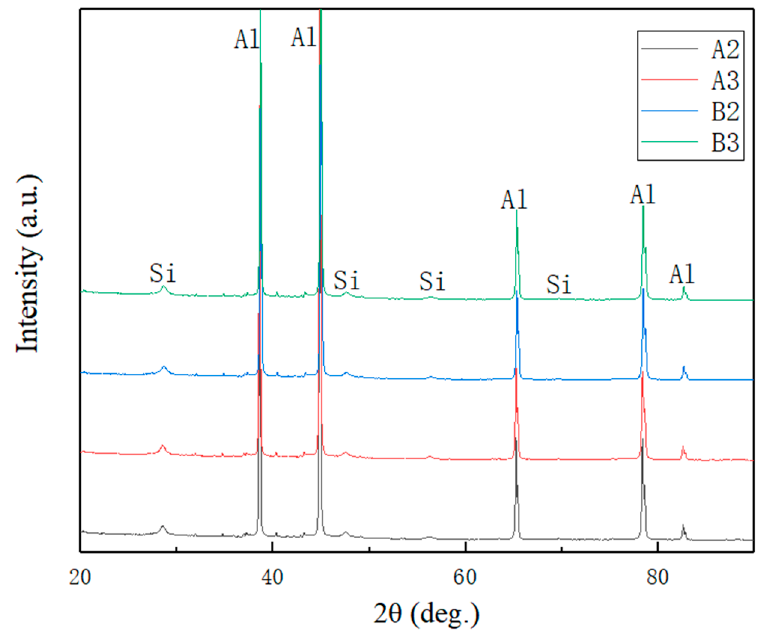
Figure 9. XRD patterns of the A2, A3, B2, and B3 samples in the as ‐ printed status. Table 3. Tensile mechanical properties of A2, A3, B2, and B3 samples in the as ‐ printed status. Ultimate Tensile No. Yield Strength/MPa Strength/MPa